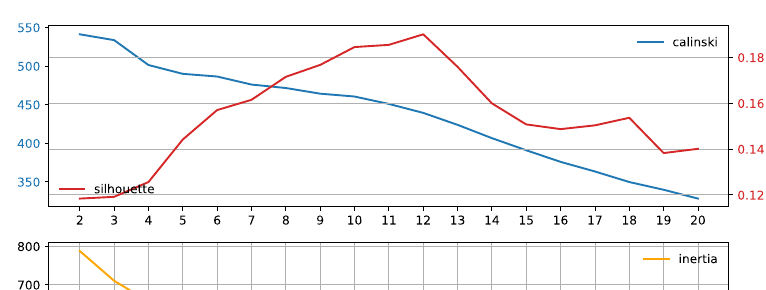
Figure A17. Subreddit e.